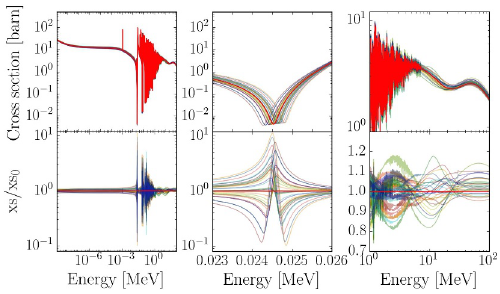
Figure 1. 56 Fe random Cross Section from the TENDL